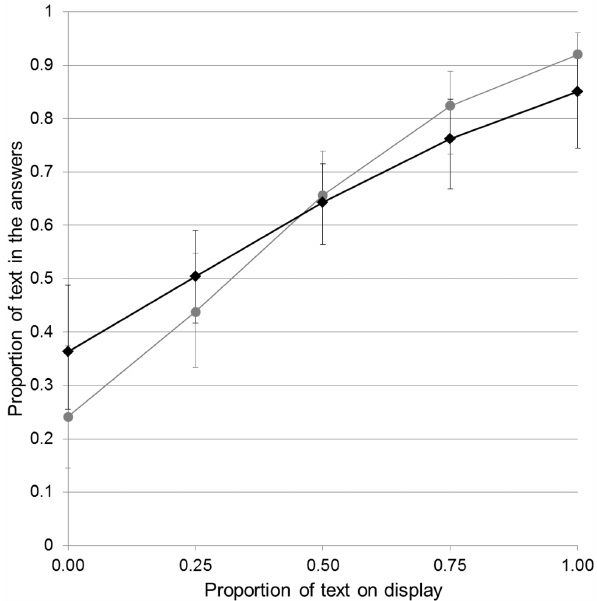
Figure 5. Effect of attention on conformity. Estimated marginal means and 95% confidence intervals for the average proportion of text in the answers for the different attention categories. (a) and (b) denote significant differences between categories.